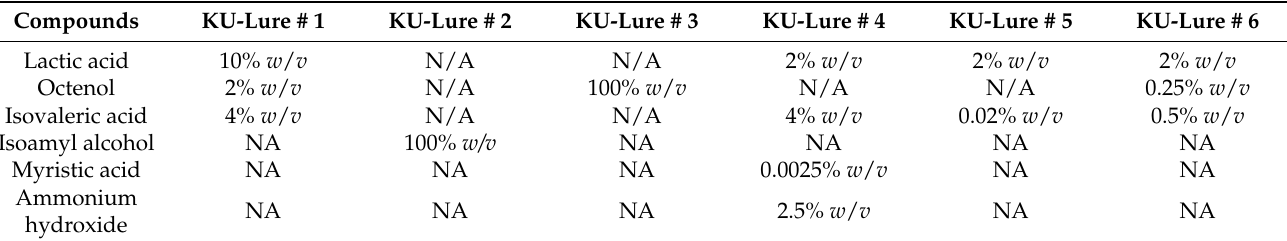
Table 1. Chemical composition of KU-lure candidates.